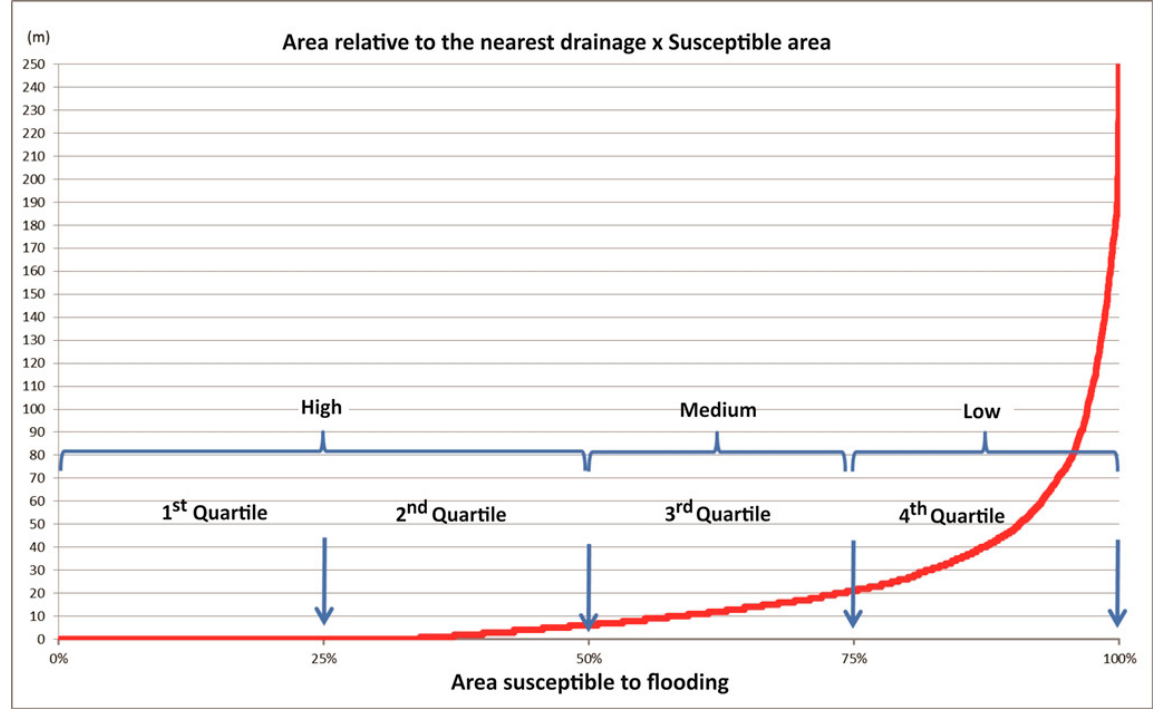
Figure 11 - Graph correlating the height relative to the nearest thalweg (HAND) with the flooding susceptible area in Conceição do Castelo, ES. The 1st and 2nd quartile data are classified as high susceptibility, 3rd quartile, as moderate susceptibility, and 4th quartile, as low